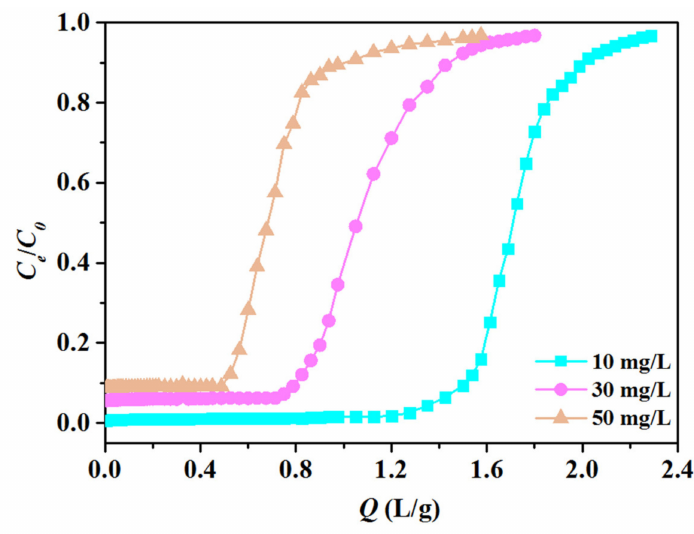
Figure 4. The breakthrough curves of NB with different initial concentrations on